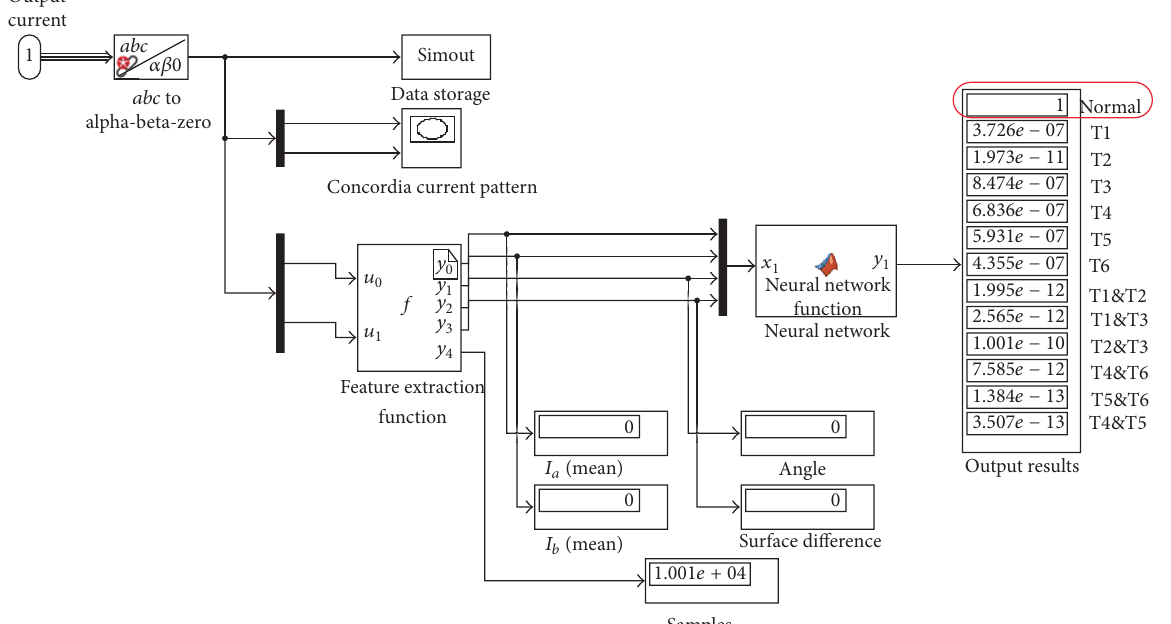
Figure 7: Internal configuration of feature extraction block with system normal mode.